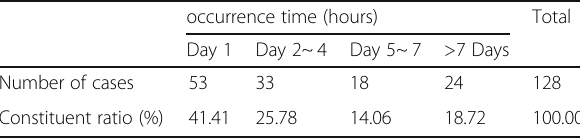
Table 5 ADR Occurrence time of